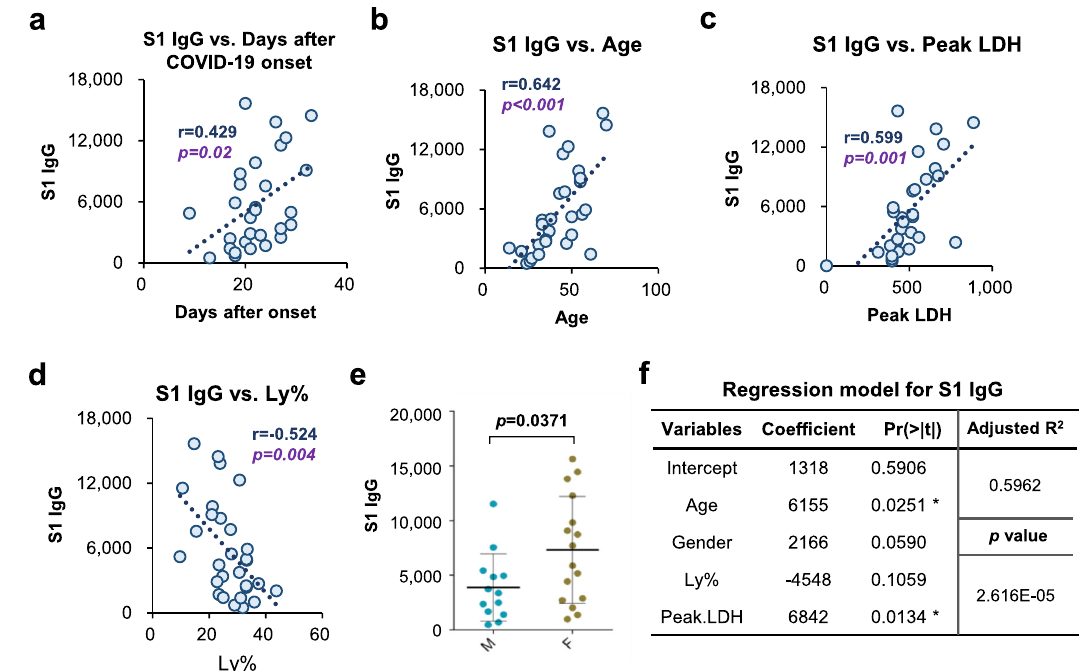
Fig. 7 Correlations with clinical characteristics. a – d Correlations of S1 IgG responses with Days after COVID-19 onset ( a ), Age ( b ), peak LDH ( c ), and Ly% ( d ). For a – d , each dot indicates one serum sample from the convalescent group ( n = 29). e S1 IgG responses in male (M, n = 13) and female (F, n = 16) groups. t- test Data are presented as mean values ± SD. For a – e , p -values were calculated by two-sided t- test. f multiple linear regression model for S1 IgG. P -values for coef fi cient was calculated by two-sided t- test and p -value for regression model was calculated by one-sided F-test. * p <